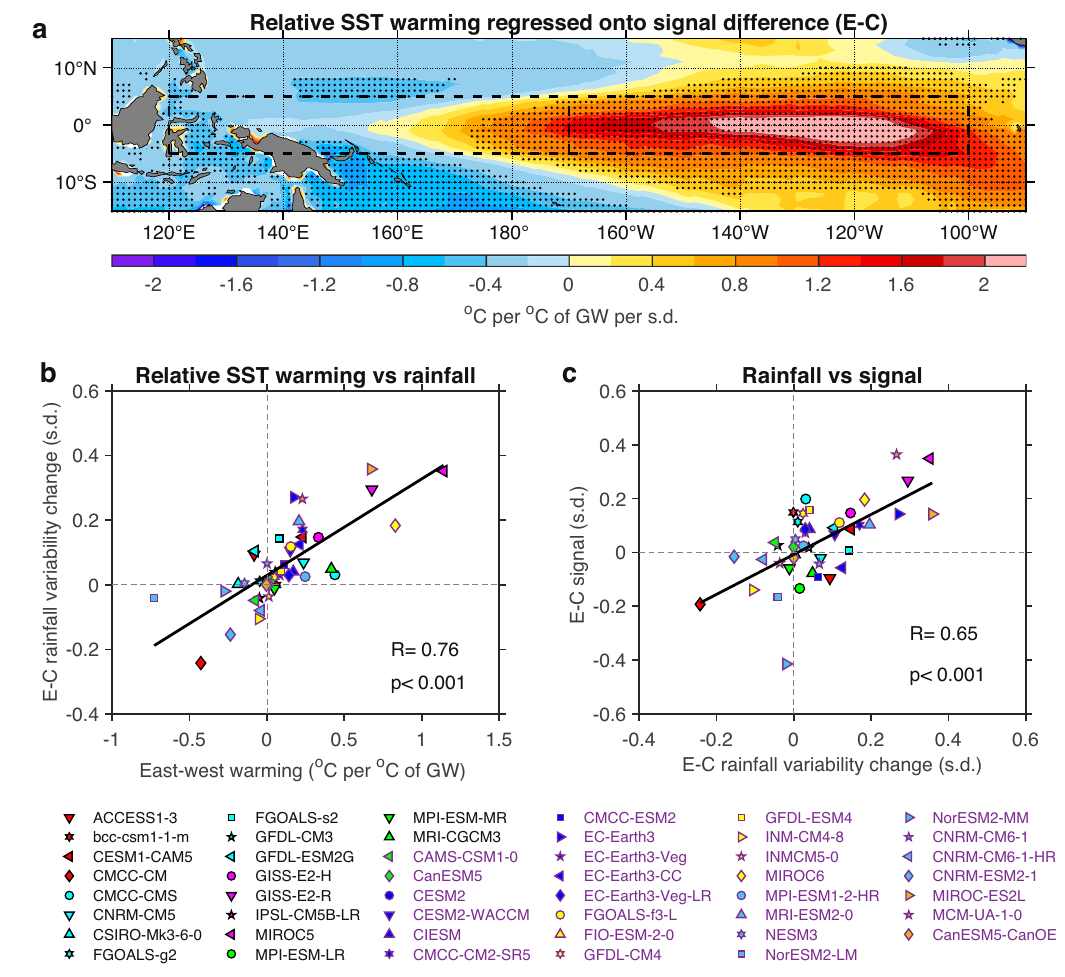
Fig. 4 | Faster eastern-Paci fi c warming facilitates stronger signal of increased eastern-Paci fi c El Niño-Southern Oscillation (EP-ENSO) sea surface tempera- ture (SST) variability. a Inter-model regression of relative SST warming onto E- minus-Csignaldifference(s.d.).RelativewarmingiscalculatedasmeanSSTchange (with 20°S – 20°N average removed) between 1960 and 2030 and piControl and scaled by corresponding global-mean SST increase (i.e. global warming, GW) between the two periods in each model. Stippling indicates statistical signi fi cance above the 95% level based on a two-tailed Student ’ s t- test. b Inter-model relation- shipbetweenzonalSSTwarmingcontrastandE-minus-Crainfallvariabilitychange.